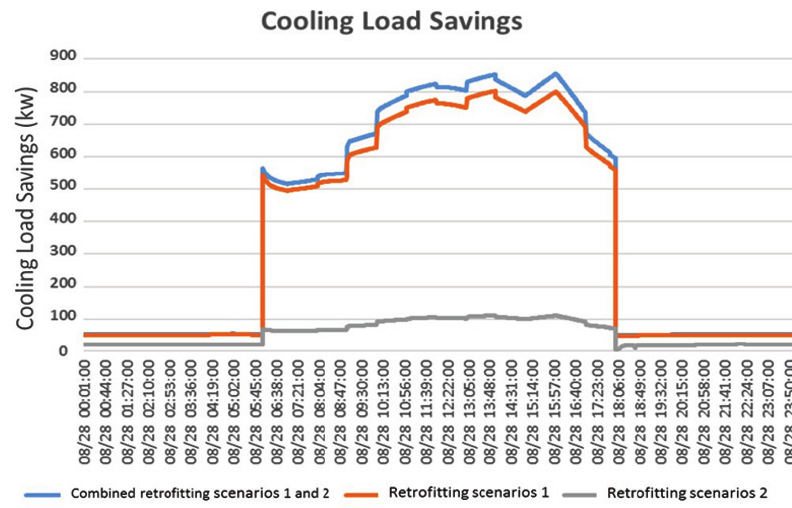
Fig. 2. Cooling load savings profile from two different retrofitting scenarios over one